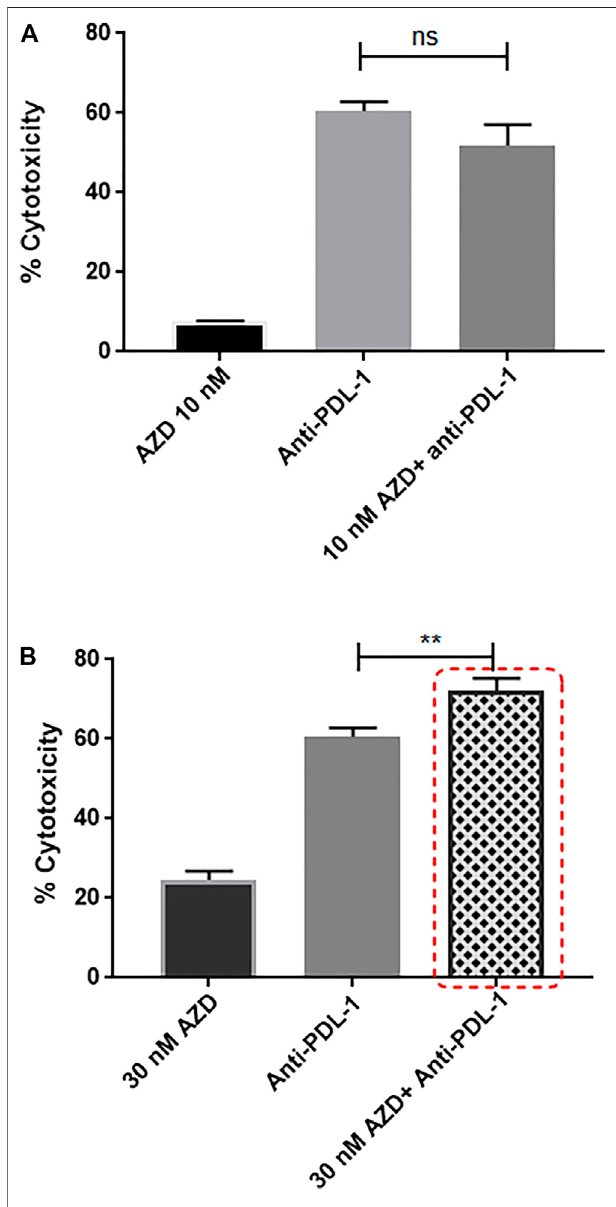
FIGURE 8 | Targeting CXCR2 ultimately fosters sensitivity to anti- PDL1 immunotherapy in MDA-MB-231 cells cultured with PBMCs. (A) Cell cytotoxicity in control and treated conditions obtained from the LDH assay. Data are expressed as cytotoxicity percentage. Anti-PDL1: atezolizumab 200 nM; AZD: AZD5069. p values. The cytotoxicity of each combined treatment group was compared to the cytotoxicity of atezolizumab alone using unpaired Student ’ s t-test, ns = p = 0.0607. (B) Cell cytotoxicity in control and treated conditions obtained from the LDH assay. Data are expressed as cytotoxicity percentage. Anti-PDL1: atezolizumab 200 nM; AZD: AZD5069. p values. The cytotoxicity